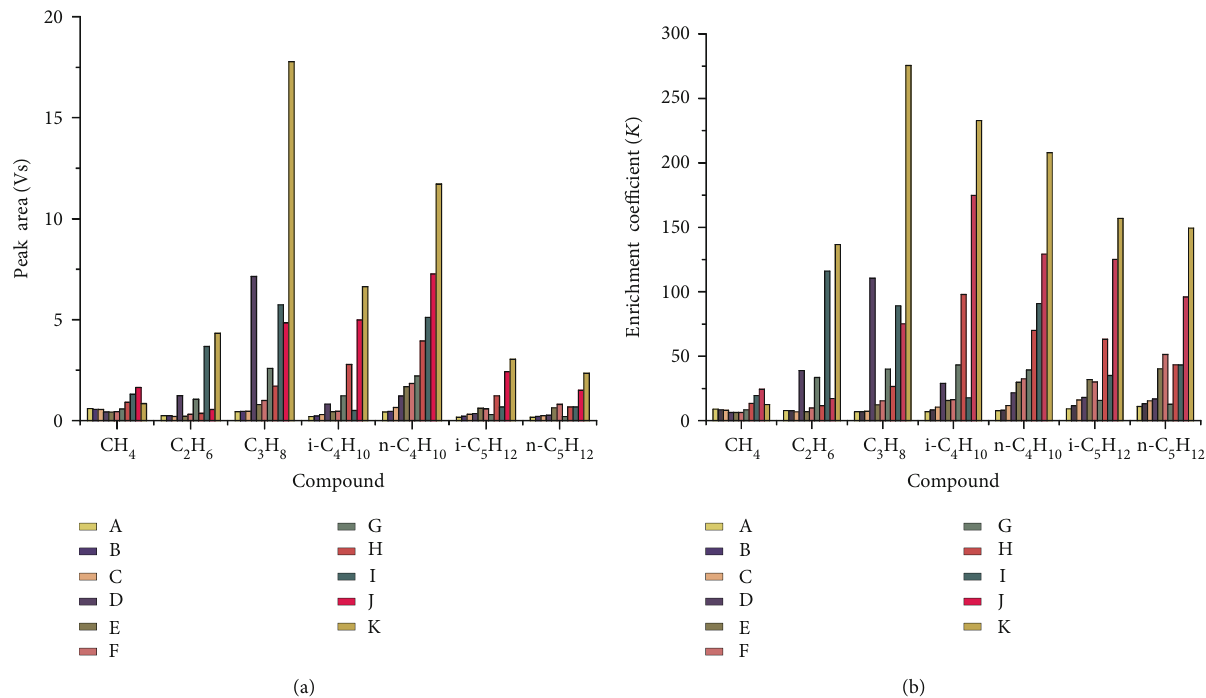
Figure 2: Comparison of adsorption e ffi ciency and enrichment coe ffi cient ( K ) of the 11 adsorbents on CH